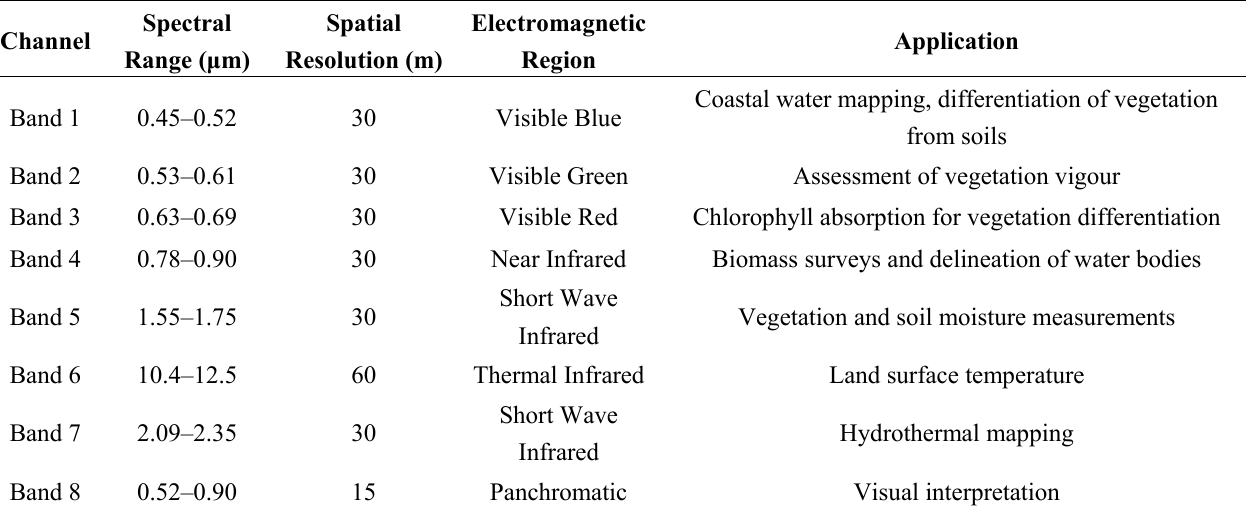
Table 1. Spectral Bands of Landsat